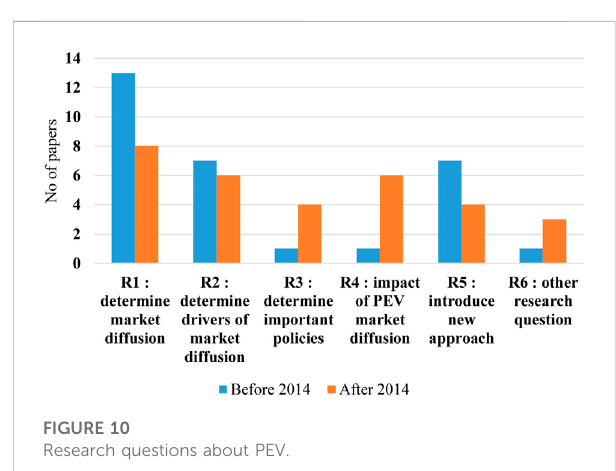
FIGURE 10 Research questions about